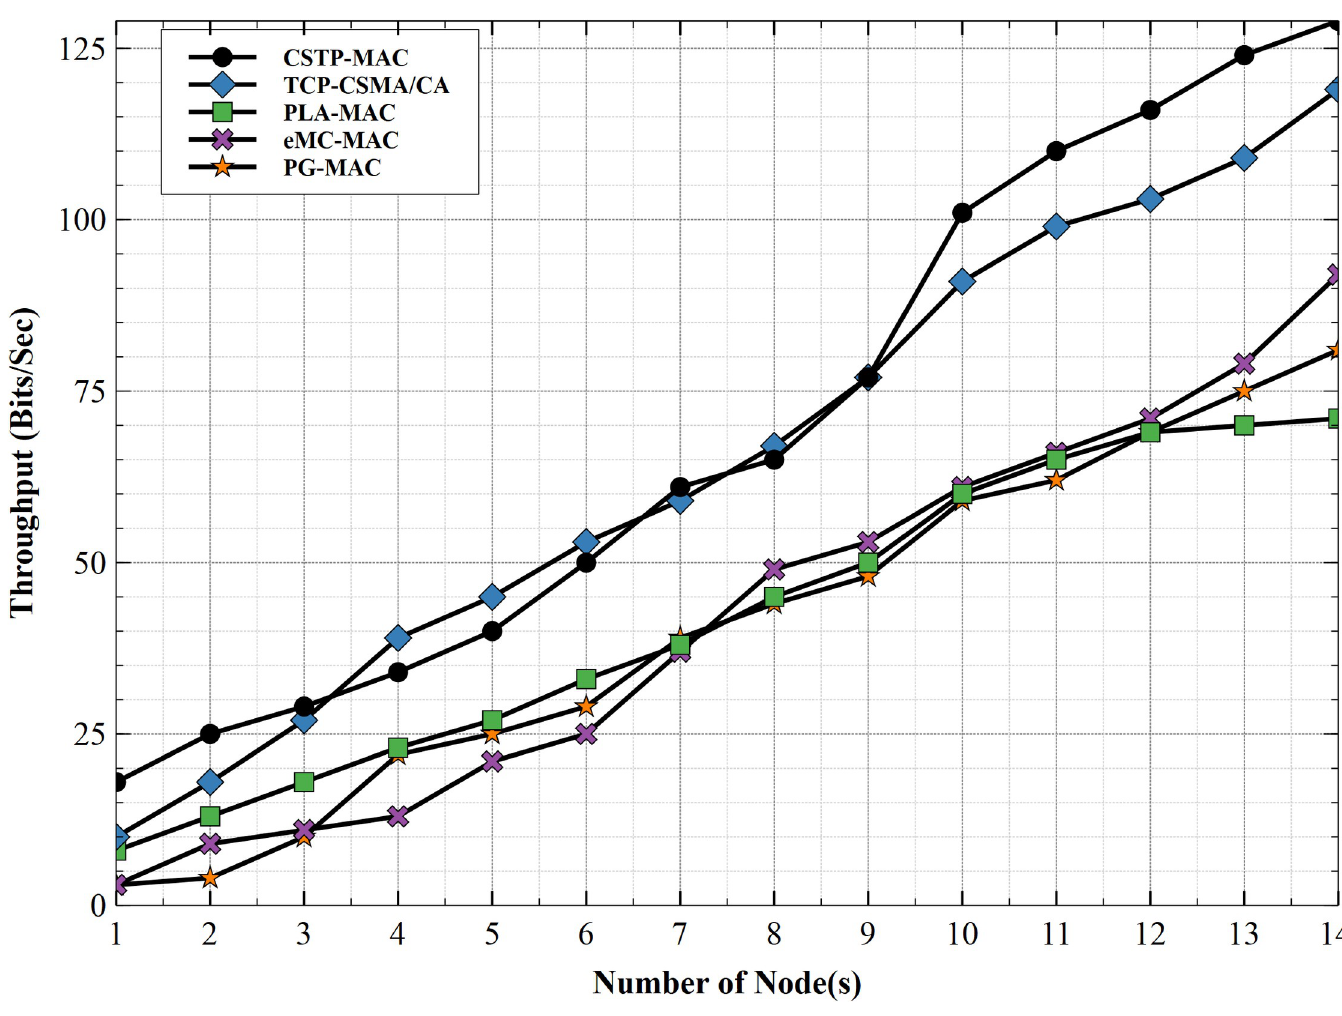
Fig 16. Throughout.